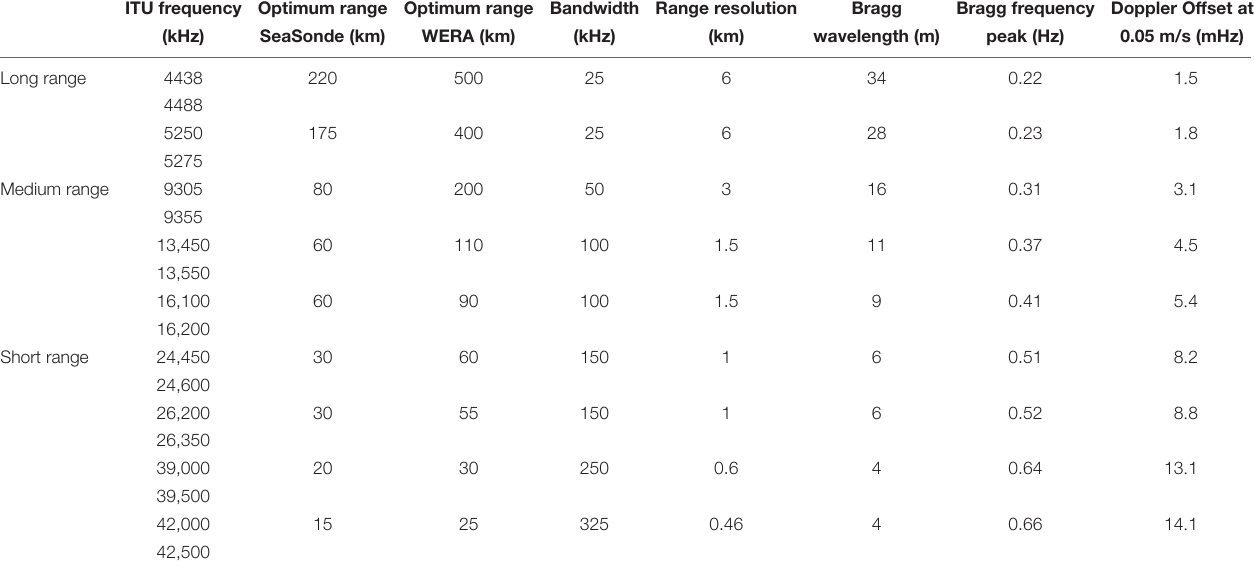
Bragg Bragg frequency Doppler Offset at